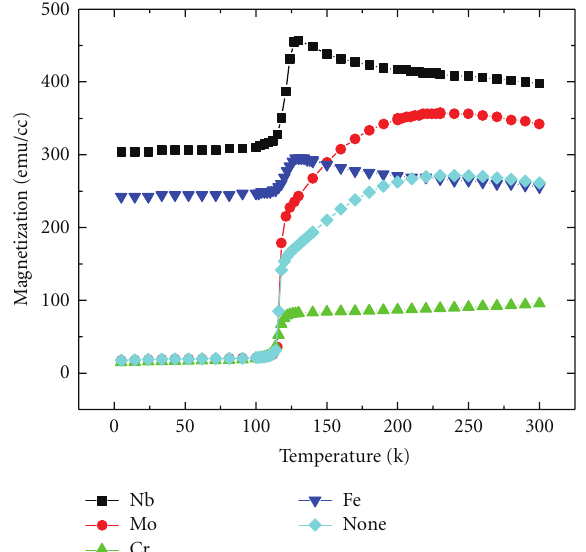
Figure 4: Temperature dependent magnetization of the Fe 3 O 4 grown on top of di ff erent bu ff er layers. These SQUID magnetome- try measurements were performed with a measurement field of 100 Oe applied along the (110) direction of the